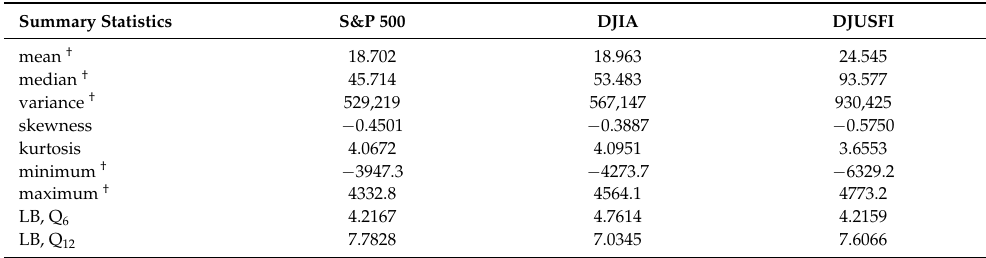
Figure 3. Histogram, ACF and time series plots for daily returns of S&P 500, DJIA and DJUSFI indices from 1 May 2013 to 31 May 2019. Table 4. Summary statistics of daily returns from 1 May 2013 to 31 May 2019 for S&P 500, DJIA and DJUSFI